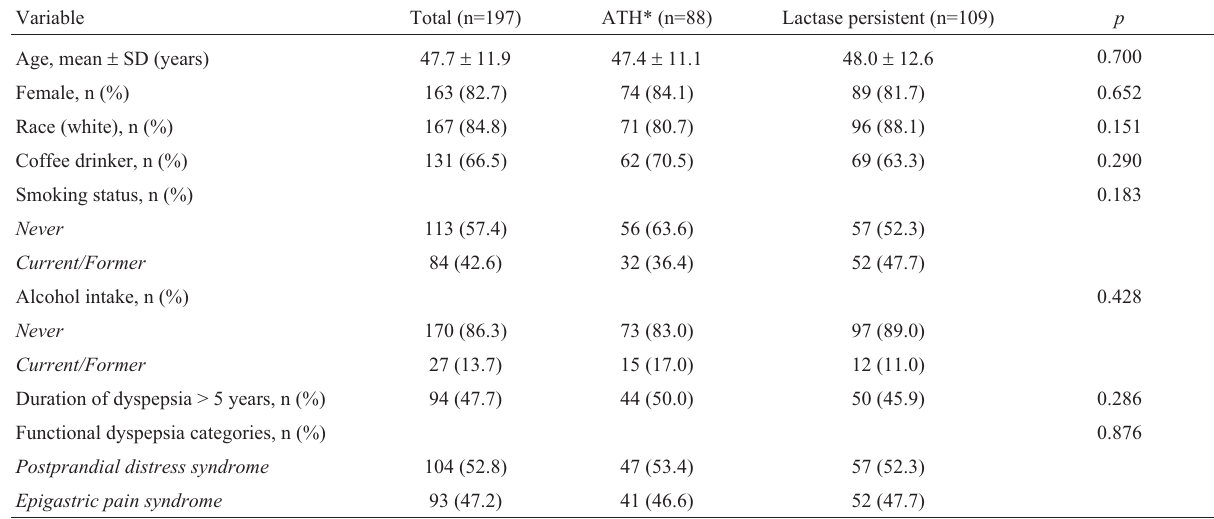
Table 1 - Demographic and clinical characteristics of 197 patients with functional dyspepsia according to lactase activity status (ATH versus lactase per- sistent). Variable Total (n=197)